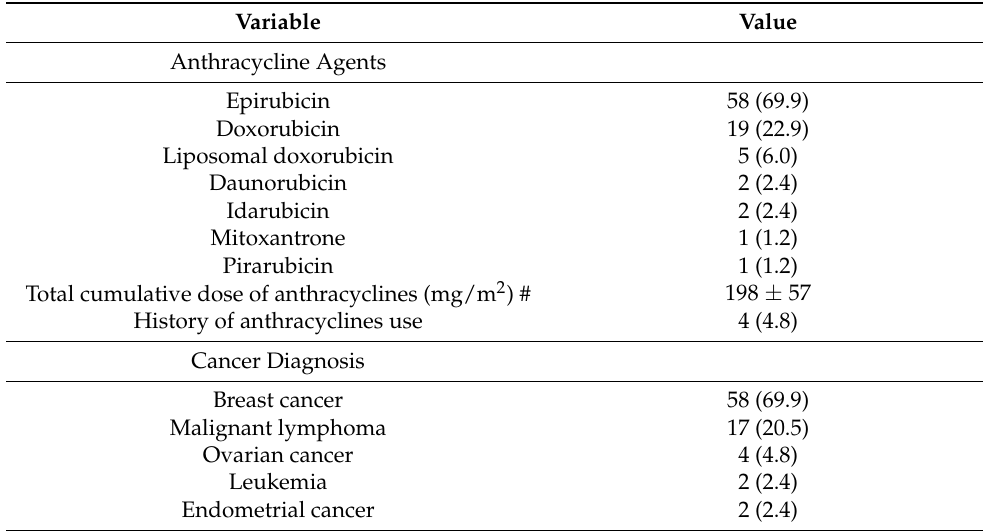
Figure 4. Behavior of echocardiographic parameters and biomarkers. The black line indicates the median; box, 25–75% range; whisker, 10–90% range. 2D: Two-dimensional, BNP: B-type natriuretic peptide, GLS: Global longitudinal strain, LVEF: Left ventricular ejection fraction, TnT: Troponin T. * p < 0.05, ** p < 0.01, Friedman test with Bonferroni post hoc test. 4. Discussion The AIC registry study was designed to investigate the incidence of anthracycline- induced cardiotoxicity, identify early marker(s) of cardiotoxicity, and evaluate the efficacy of HF treatment against cardiotoxicity. This is the first study to collect sizable echocardi- ographic and biomarker data on cardiotoxicity over time in Japanese cancer patients in a real-world setting. This study will generate important information including the